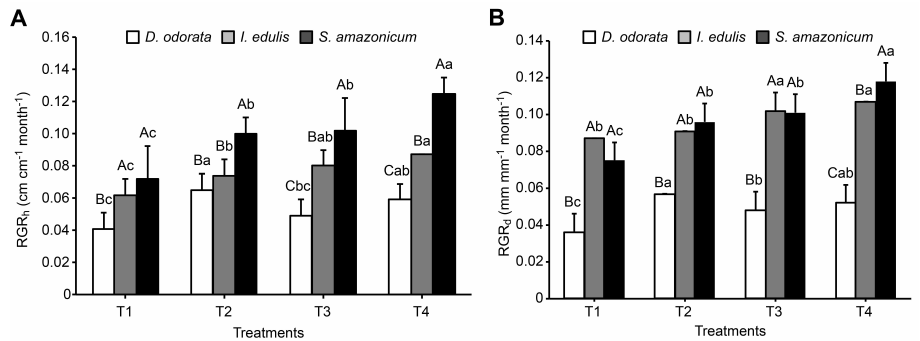
Figure 2. Relative growth rates of the ( A ) height (RGR height ) and ( B ) diameter (RGR diameter ) of the three leguminous trees in all of the fertilization treatments 11 months after planting. T1 = no fertilization, T2 = post-planting chemical fertilization, T3 = post-planting organic fertilization and T4 = combined chemical and organic post-planting fertilization. Mean of six samples ( ˘ SD); mean values followed by the same letters did not differ between the treatments at p ď 0.05 based on Duncan’s test. Uppercase letters compare the three species within the same fertilization treatment, and lowercase letters compare different fertilization treatments for each species. Table 4. Absolute growth rates of leaf biomass (AGR leaves ), stem biomass (AGR stems ) and root biomass (AGR roots ) of three leguminous trees in all of the fertilization treatments 11 months after planting. T1 = no fertilization, T2 = post-planting chemical fertilization, T3 = post-planting organic fertilization, and T4 = combined chemical and organic post-planting